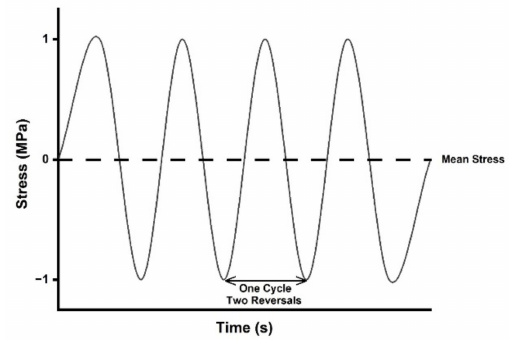
Figure 3. Sinusoidal pattern created by fully reversed loading. The sinusoidal pattern results from the alternation of tensile (reversal 1) and compressive (reversal 2) loading during